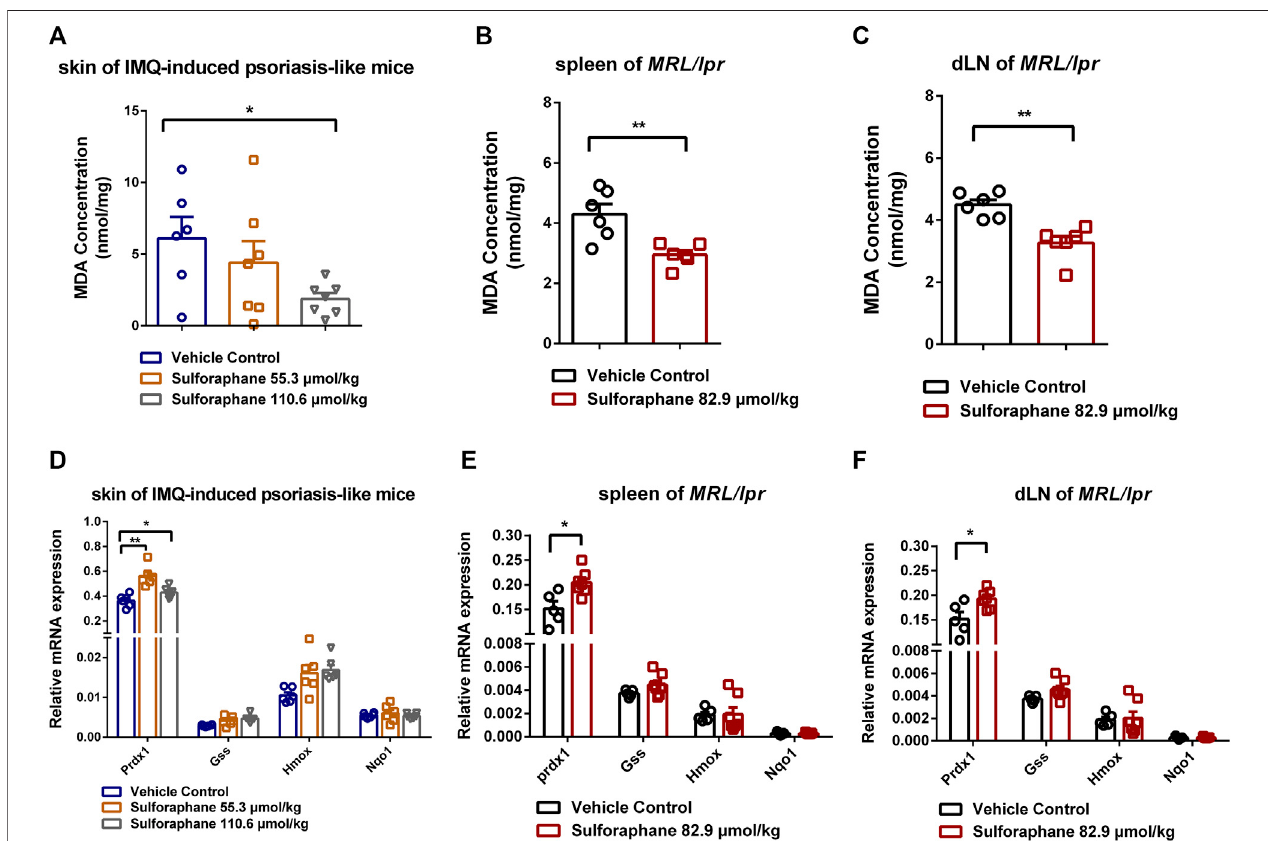
FIGURE 5 | Sulforaphane upregulated the antioxidant gene Prdx1 expression to reduce the level of oxidative stress. (A) The concentrations of MDA in skin of IMQ-inducedpsoriasis-likemicetreatedwithsulforaphaneorvehiclecontrol(n (cid:1) 5 – 6). (B,C) TheconcentrationsofMDAinthespleens (B) anddLNs (C) ofMRL/lprmice treated with sulforaphane or vehicle control (n (cid:1) 5 – 6). (D) The relative mRNA expression of Prdx1 , Gss , Hmox1 , and Nqo1 in skin of IMQ-induced psoriasis-like mice treatedwithsulforaphaneorvehiclecontrol(n (cid:1) 5 – 6). (E,F) TherelativemRNAexpressionof Prdx1 , Gss , Hmox1 ,and Nqo1 inthespleens (E) anddLNs (F) ofMRL/ lpr mice treated with sulforaphane or vehicle control (n (cid:1) 5 – 6). The data represent the mean ± SEM. * p < 0.05, ** p <